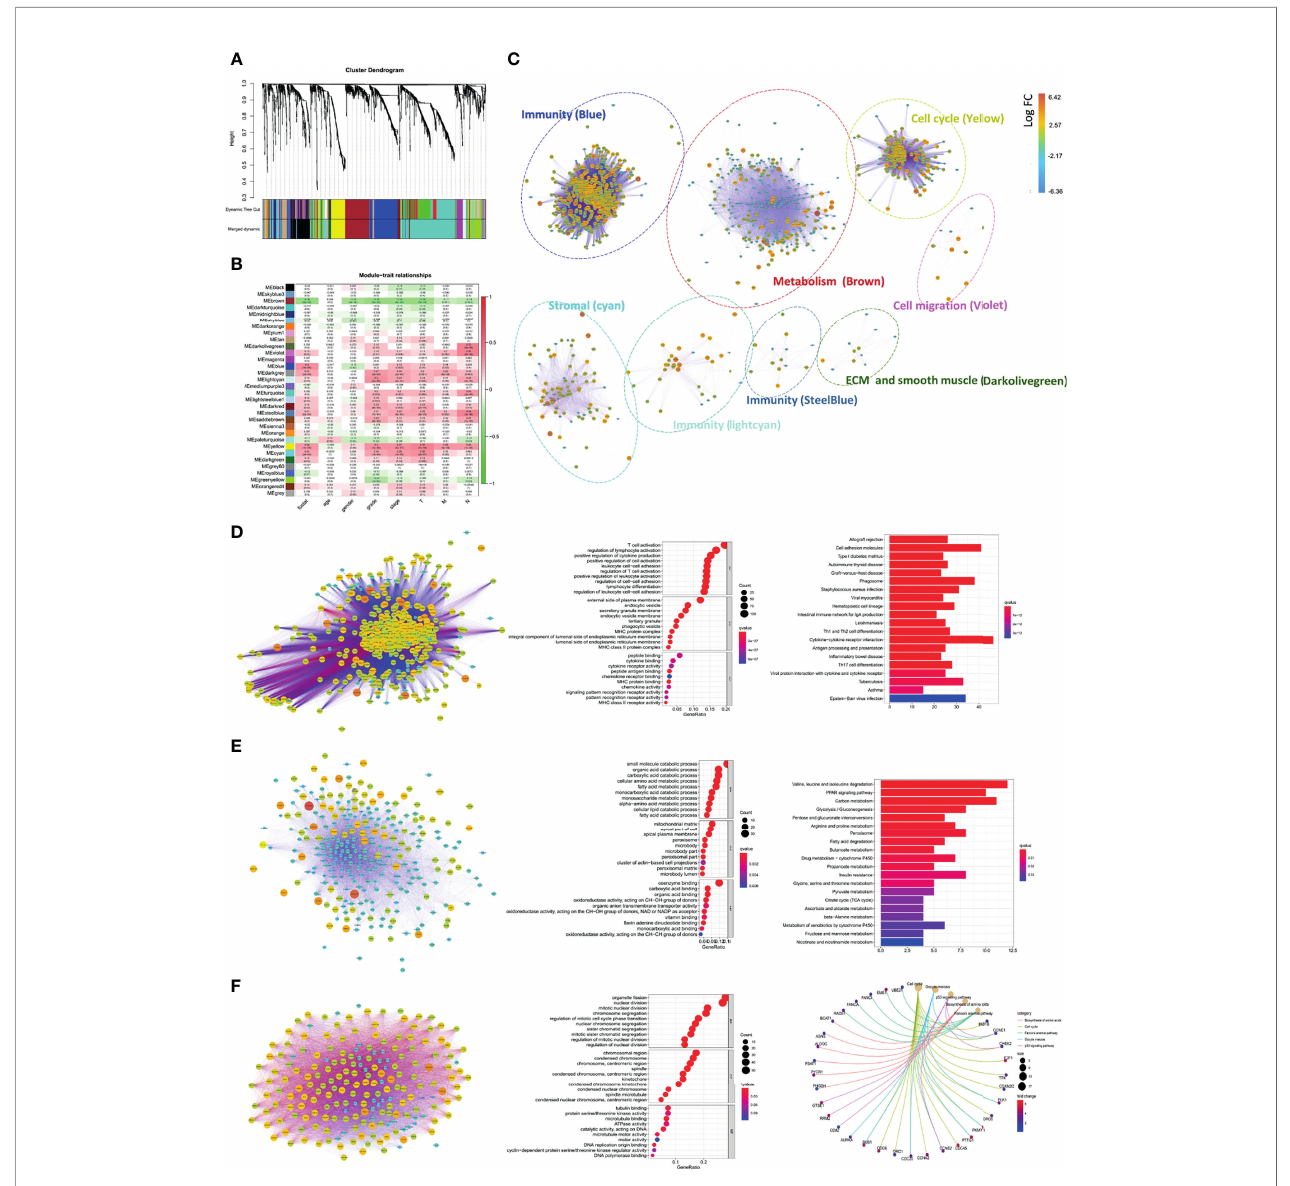
FIGURE 7 | Comprehensive annotation for the functions of CD248 + CAFs regulatory DEGs. (A) Clustering dendrograms of genes and clinicopathological variables, with dissimilarity based on topological overlap, together with assigned module colors. (B) Module – trait associations. The rows correspond to module gene sets, and columns correspond to a trait. Cells contain the corresponding correlation and p -value. The table is color-coded by correlation according to the color legend. (C) PPI network for the 8 selected gene modules. The function of each module is marked. Labels are colored according to the color legend. (D) PPI network and bubble diagram of the GO analysis and bar chart of KEGG pathway analysis for the “ Blue ” module. (E) PPI network and bubble diagram of the GO analysis and bar chart of KEGG pathways analysis for the “ Brown ” module. (F) PPI network and bubble diagram of the GO analysis and Circos chart of the KEGG pathway analysis for the “ Yellow ” module. p < 0.05 was considered statistically signi fi